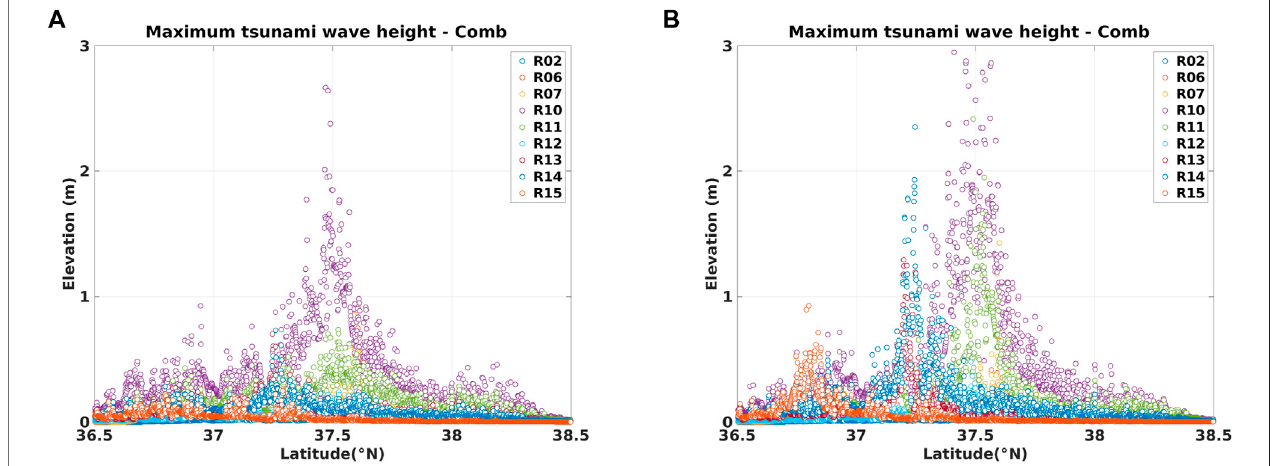
FIGURE 10 | Maximum tsunami wave height along the eastern coast of the Korean Peninsula, estimated from modeling for 11 scenarios ( “ R ” ) and 2 combinations [ (A) : Combination A; (B) : Combination B] of fault parameters.